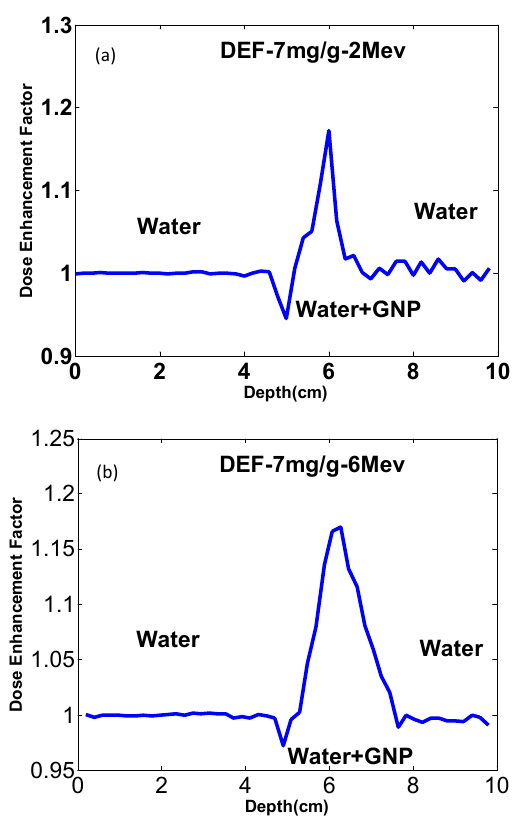
Fig. 3. The absorptive DEFs for GNPs of 50 nm: (a) energy of 2 MeV, (b) energy of 6 MeV Fig. 3 The absorptive DEFs for GNPs of 50 nm: (a) energy of 2 MeV, (b) energy of 6